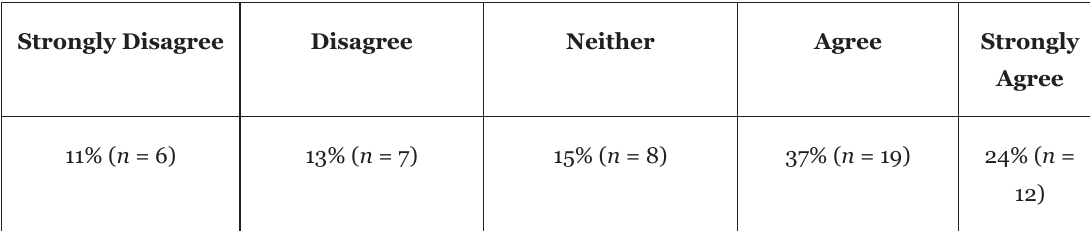
Responses to the Question about the Helpfulness of Support Staff during the Transition